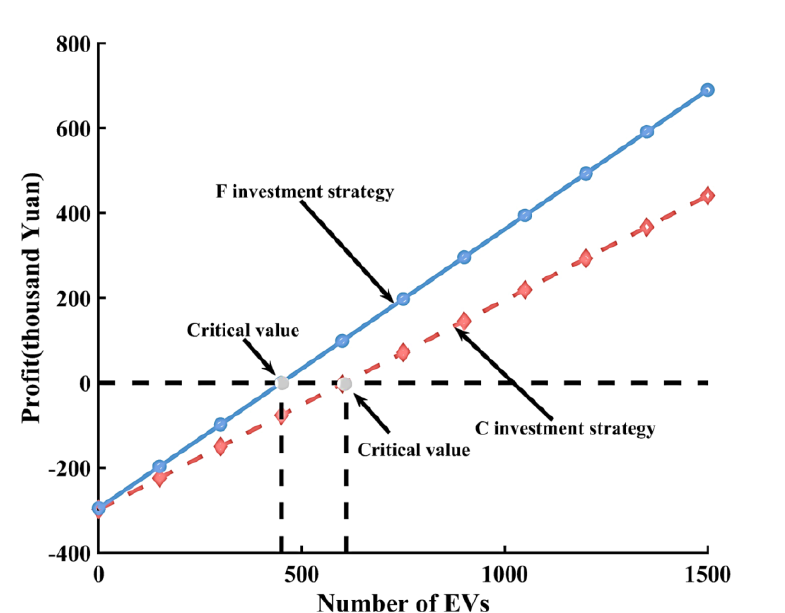
Figure 3. ECF-investment profit changes with number of